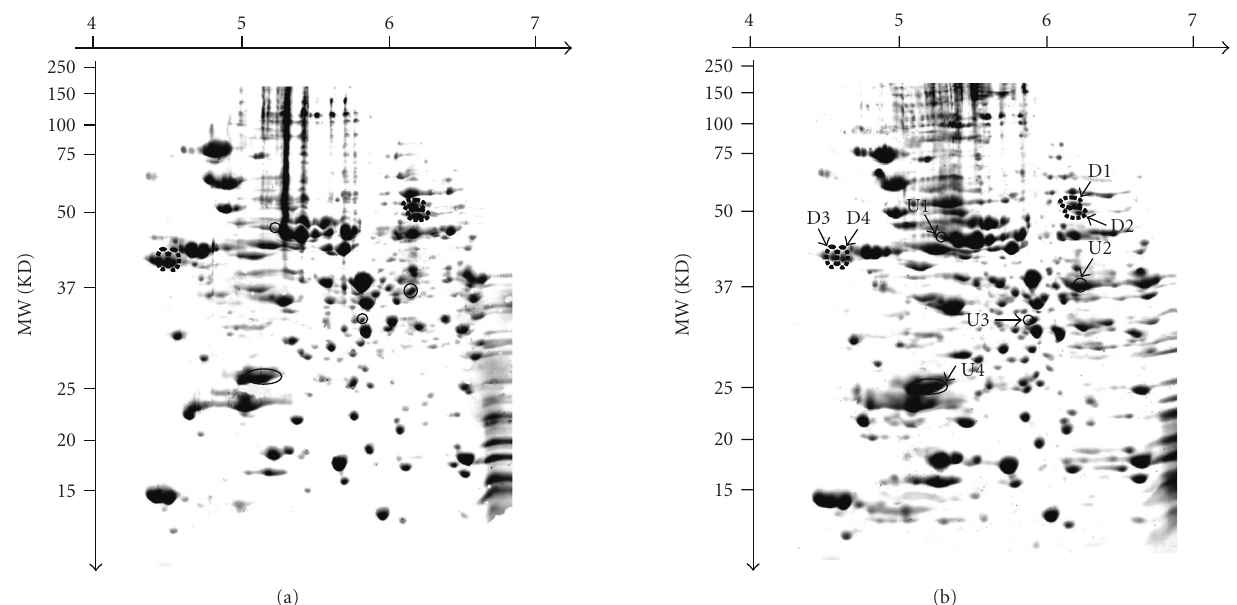
Figure 2: 2DE maps of E. coli strains with stationary-phase cultures in BHI medium . (a) E44 (wild type strain). (b) BR2 (the ibeR deletion mutant). The upregulated proteins were circled with a solid line and marked with U1–U4; the downregulated proteins were circled with a broken line and marked D1–D4.